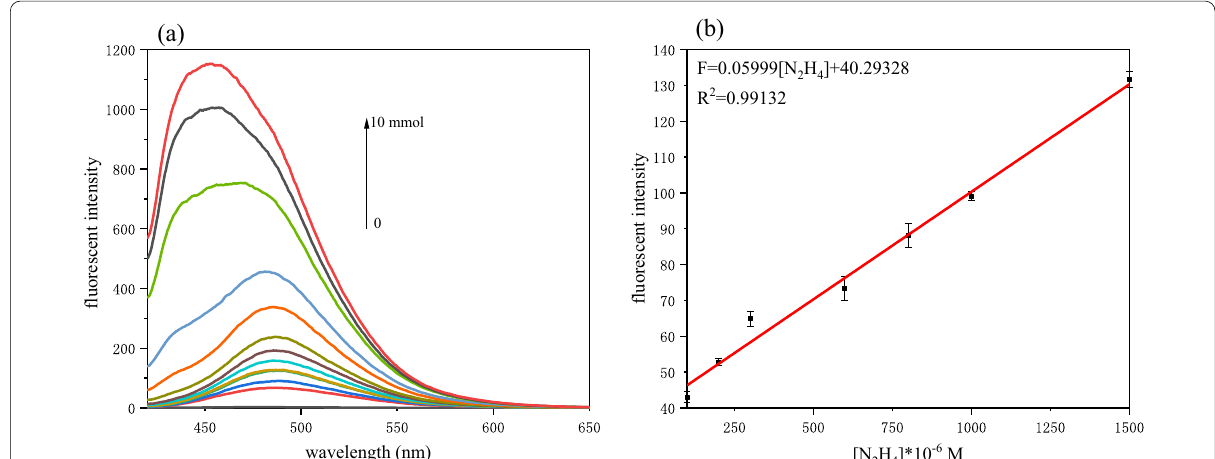
Fig. 4 a Fluorescence spectral changes of BCD (60 µM) toward different concentrations of N 2 H 4 in the DMF-Hepes buffer (7/3, v/v, pH Linear responses of fluorescent intensity at 458 nm to varying N 2 H 4 concentration